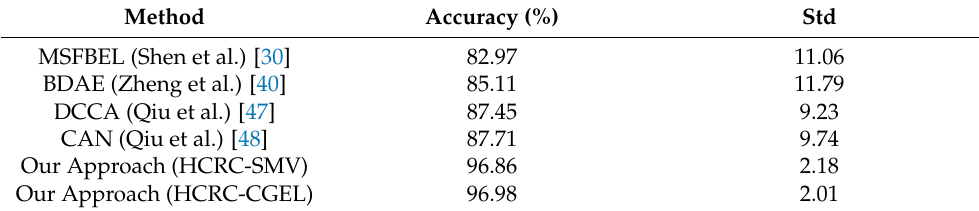
Table 5. Mean accuracy and standard deviations (Std) on SEED IV